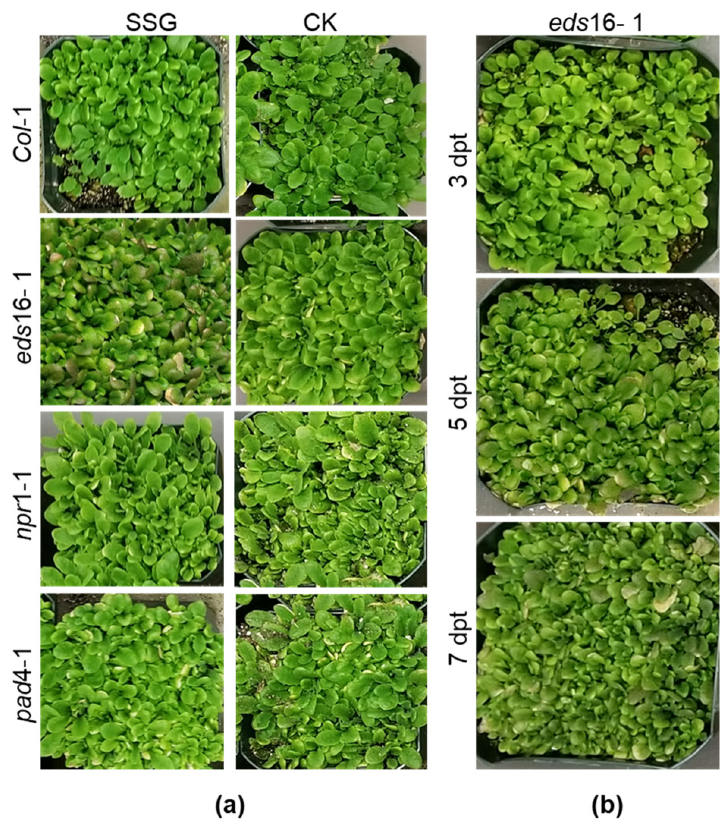
Figure 5. Responses of Arabidopsis to Burkholderia sp. SSG. Four weeks-old plants were sprayed with SSG at 10 8 to 10 9 CFU mL − 1 PBS or the control CK, PBS alone. ( a ) The morphology of Col-0 and its mutants at 10 days post-treatment (dpt). ( b ) Symptom development on eds 16-1 after SSG spray.